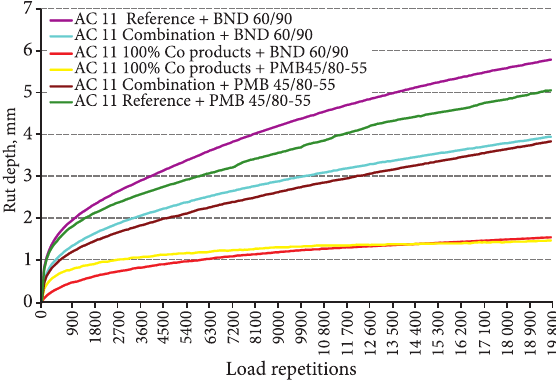
fig. 5. Wheel tracking test results